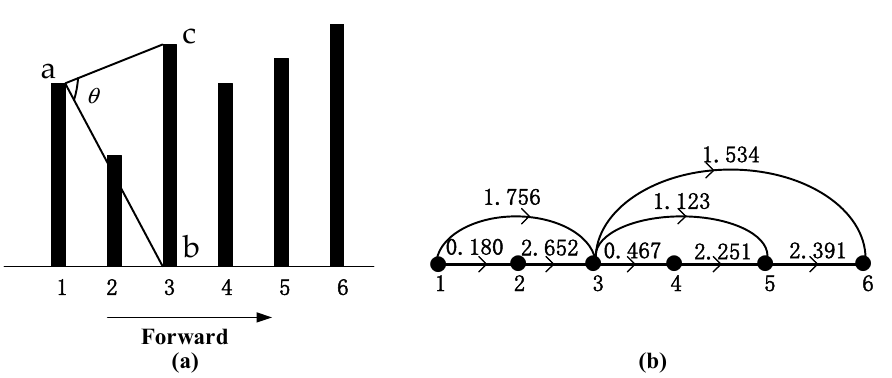
6 of 22 Figure 2. Horizontal visibility graph of a time series. ( a ) The histogram of time series; ( b ) Its corre- sponding HVG. 3.3.2. Directed Weighted Horizontal Visibility Graph HVG with edge weight is known as the weighted horizontal visibility graph (WHVG), where the link between two nodes are not binary values (0 and 1). There are two commonly used edge weights at present, namely distance [39] Error! Reference source not found. and radian function [40]. We proposed a novel directed weighted hor- izontal visibility graph (DWHVG). The edge weight is related to visibility angle measure- ment. The weighted complex network can be expressed by a weight matrix (cid:1797) = ((cid:1875) (cid:3036)(cid:3037) ) (cid:3015)(cid:3051)(cid:3015) . The edge weight w ij is the angle between no des i and j . It can be described as follows: if no des i and j is visible, the connection of the vertex i and vertex j is called ab , and the connection of the vertex i and bottom j is called ac . The edge weight w ij is the angle between ab and ac , as shown in Figure 3a. Equation (3) is the edge weight of FWHVG. Equation (4) is the edge weight of BWHVG: arctan